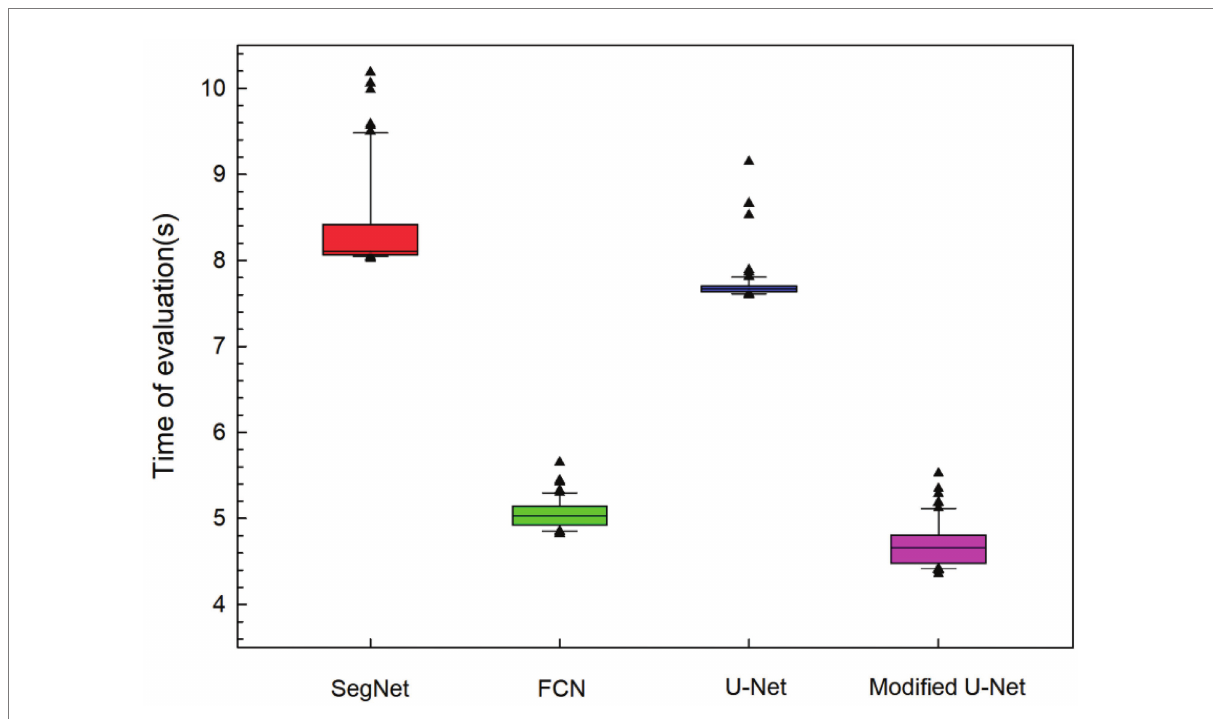
FIGURE 11 Time required by different models for residual film evaluation on the